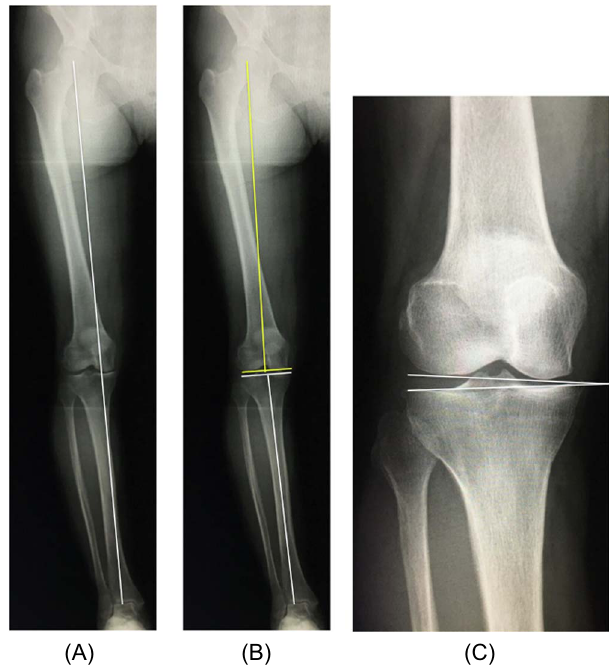
Figure 2. Radiological parameters. (A) The weight-bearing line (WBL) was de fi ned as the line drawn from the center of the femoral head to the center of the superior articular surface of the talus. The WBL ratio was de fi ned as the tibial insertion of the weight-bearing line/tibial width, with the medial tibial edge at 0% and the lateral tibial edge at 100%. (B) The mechanical lateral distal femoral angle (LDFA) was de fi ned as the angle between the femoral mechanical axis and the articular surface of the distal femur (yellow line). The medial proximal tibial angle (MPTA) was de fi ned as the angle between the tibial mechanical axis and the articular surface of the proximal tibia (white line). (C) The joint line convergence angle (JLCA) was de fi ned as the angle of the two articular surface lines of the distal femur and the proximal